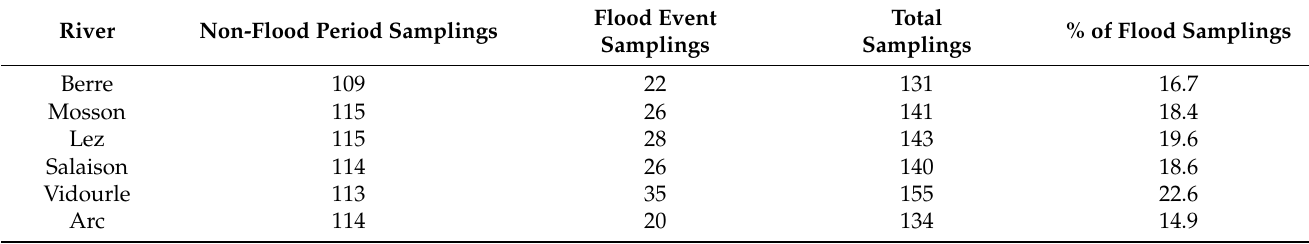
Table 2. Number of samplings performed during non-flood periods and flood